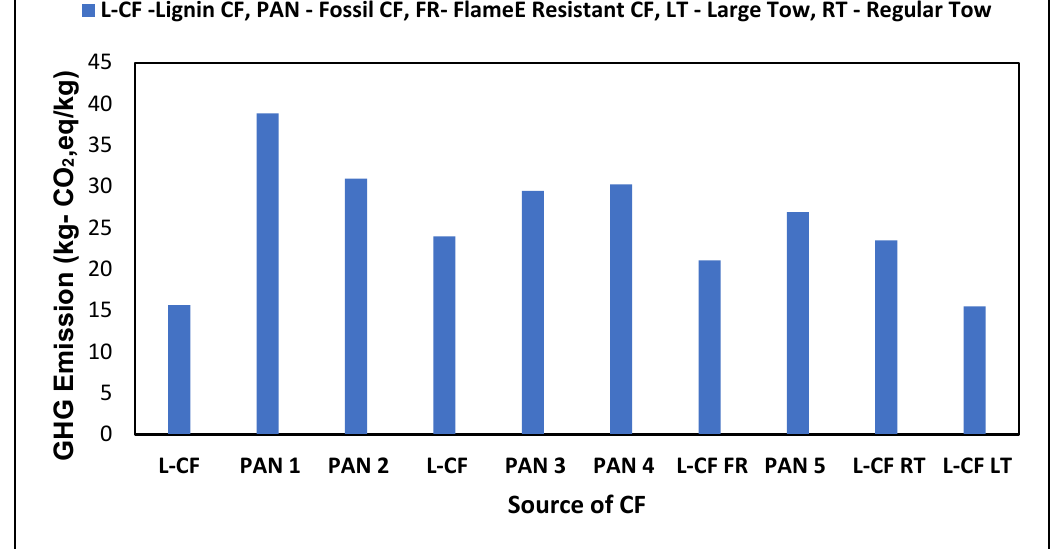
Figure 5. Comparison of GHG emissions from lignin-based CFs and PAN based CFs. Also, Sakamoto [87] examined the GHG emissions from APs and PAN CFs. For the GHG emissions from the AP CFs two methods were presented; the classical method and coupling method. The GHG emissions of the entire CF production process were the sum of the GHG emissions from the precursor-fiber preparation and the CF production representa- tive of both large tow (LT) and regular tow (RT). Finding shows that the GHG emissions from the CFs from PAN, from the APs (RT) and APs (LT) from the classical method, and from the APs from the coupling method were 26.94, 23.53, 15.53, and 40.68 kg-CO 2 eq/kg, respectively. Compared with the conventional PAN based CFs, GHG emissions from the AP CFs from the classical method (RT) were 11% lower, and those from the AP CFs from the classical method (LT) were 42% lower. GHG emissions from the AP precursors were 20.49 kg-CO 2 eq/kg and those from PAN were 10.08 kg-CO 2 eq/kg. Notably, the